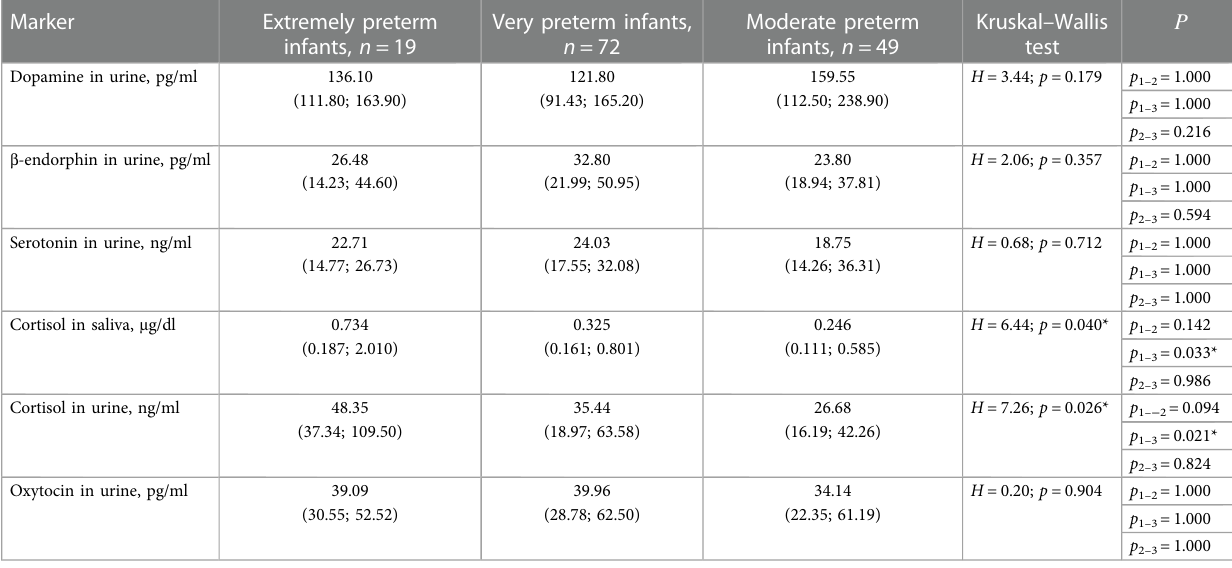
TABLE 3 Laboratory markers of chronic pain and stress in preterm